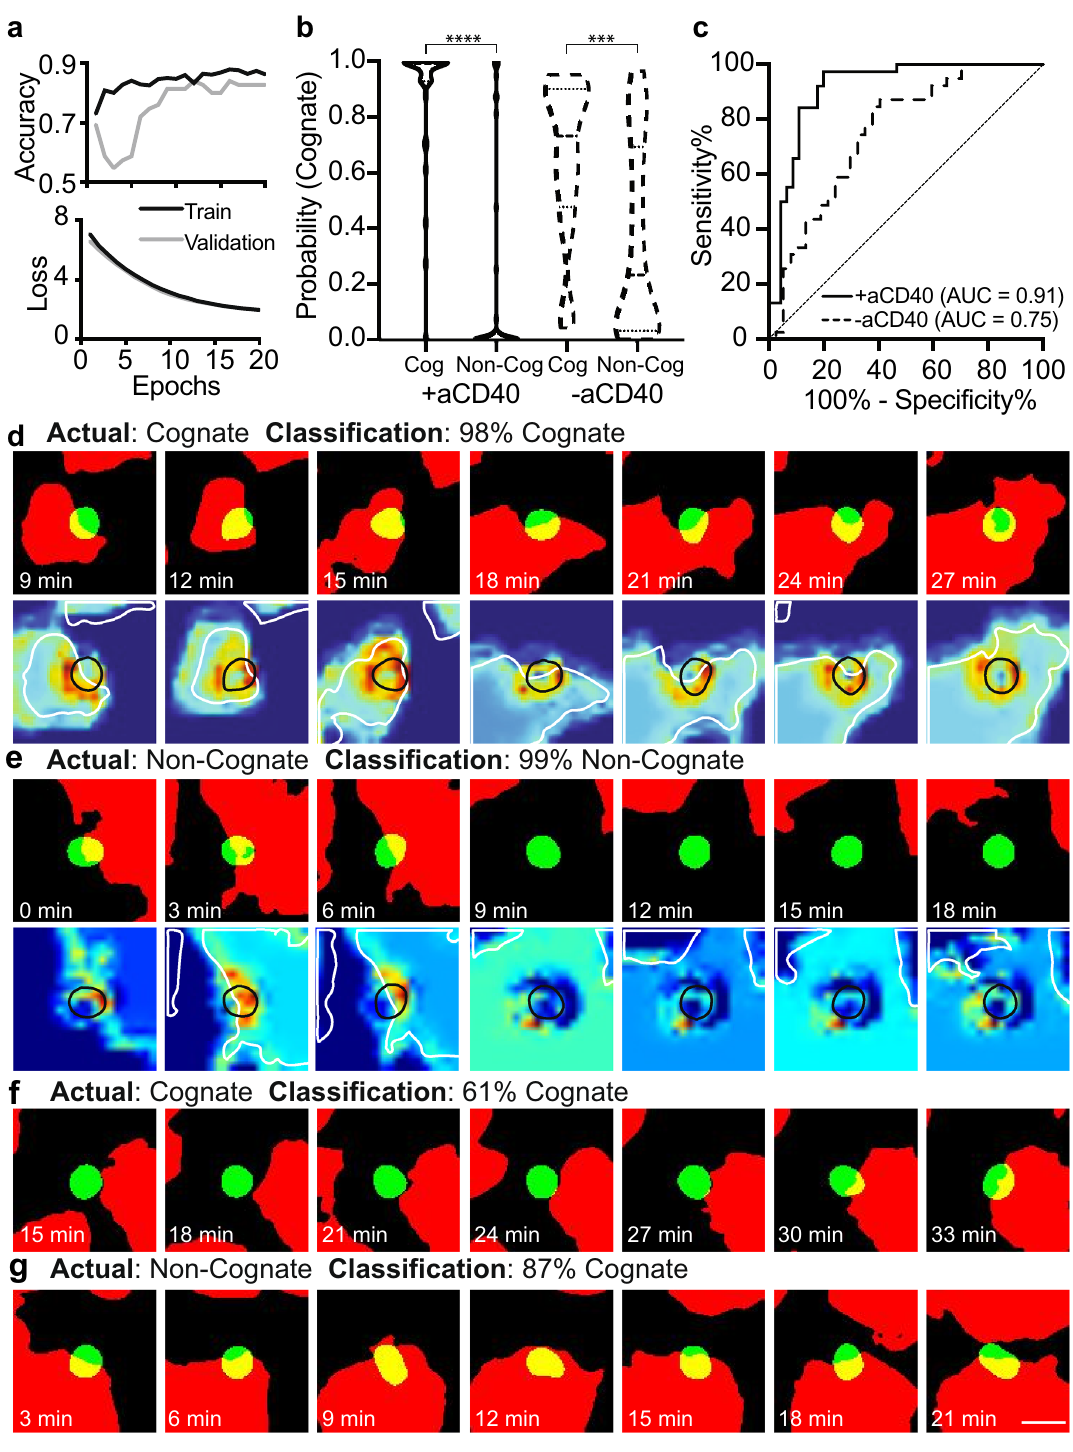
Figure 3. Using deep learning to classify cognate vs. non-cognate T cell-DC interactions, with or without aCD40. ( a ) Accuracy and loss curves during training and validation of the deep learning model using high affinity cognate and non-cognate OT-I T cells incubated with aCD40. ( b ) Predicted probability that an OT-I T cell is cognate using models trained and tested on datasets with or without aCD40. ( c ) ROC curves quantifying the ability of the deep learning models to discriminate between cognate and non-cognate T cells based on the probabilities predicted in ( b ). ( d )–( e ) Examples of T cells which were correctly, and with a high probability classified as ( d ) cognate, and ( e ) non-cognate. ( f )–( g ) Examples of T cells which were ( f ) correctly classified as cognate with a lower probability and ( g ) incorrectly classified as cognate. In ( d ) and ( e ), the Grad-CAM heatmaps visualize the regions important for the designated classification in red (DC outline is overlaid in white, and T cell outline is overlaid in black). Scale bar is 10